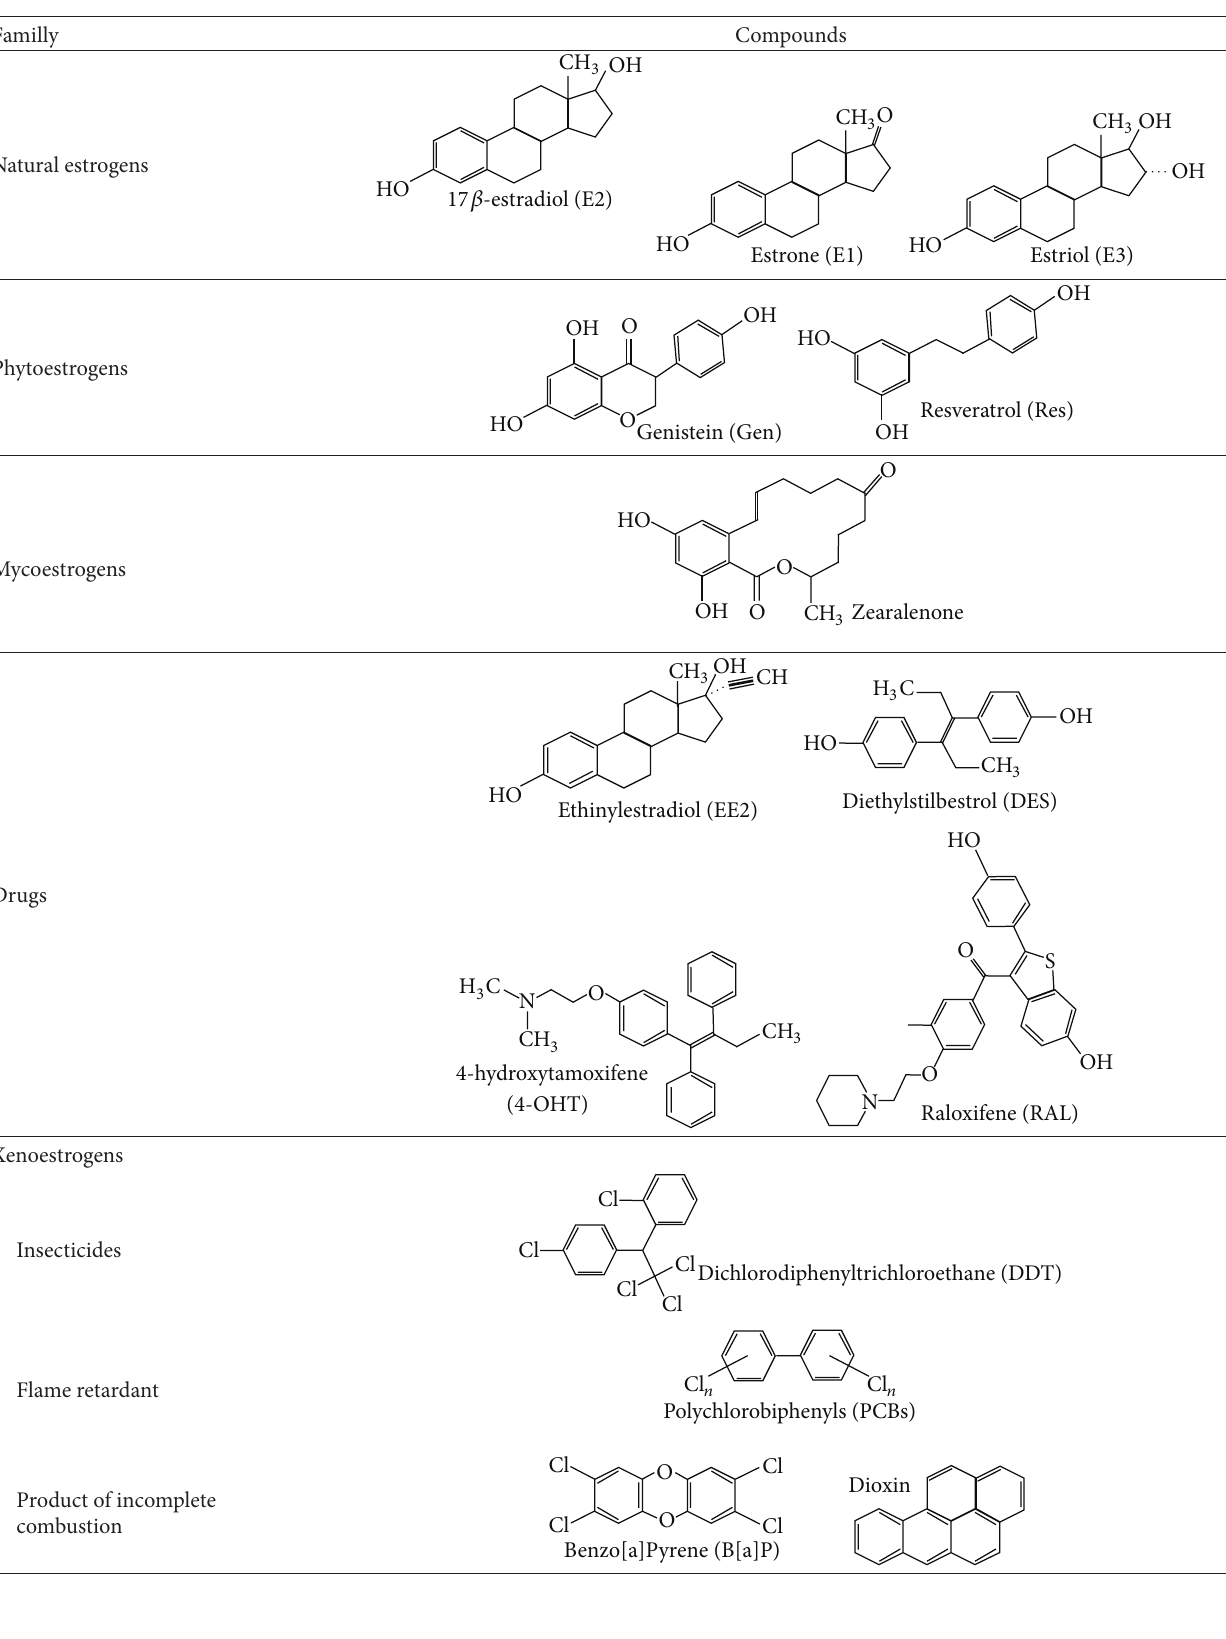
Table 1: Illustration of the structural diversity of estrogenic compounds from diverse